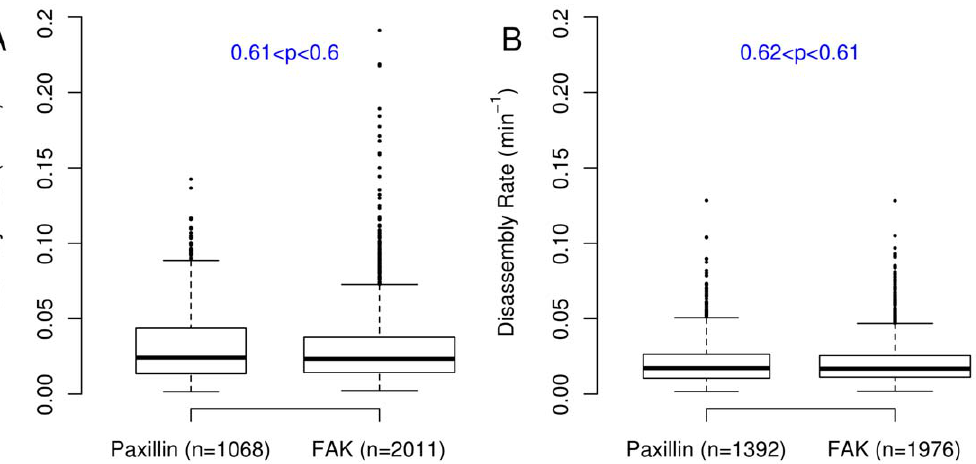
Figure 5. The assembly and disassembly rates of EGFP-Paxillin and EGFP-FAK adhesions are the same. The blue numbers in each plot are the p-values of the difference in median values between the EGFP-Paxillin and EGFP-FAK adhesions. P-values were calculated using the bootstrapped confidence intervals with 50000 replicates. Data from 10 cells are included.